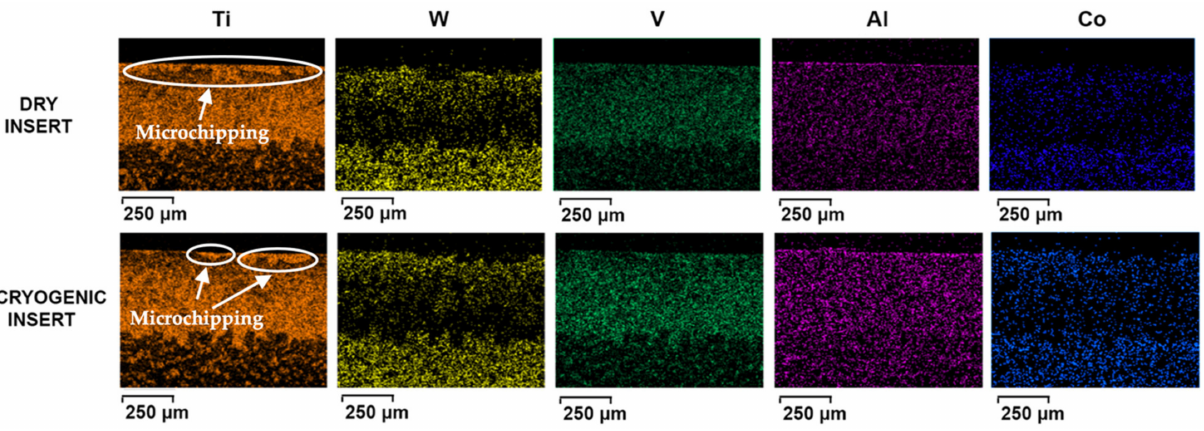
Figure 13. EDS element maps for dry and cryogenic